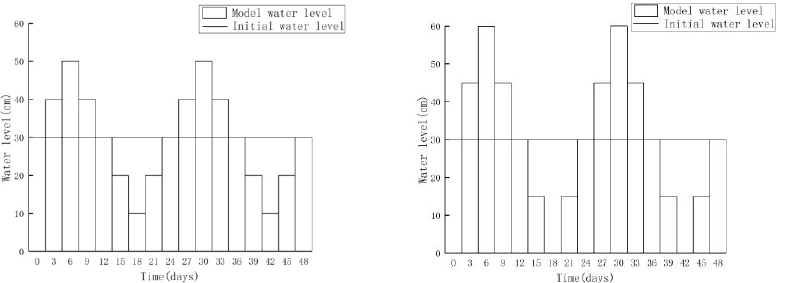
Figure 7. Comparison of water level changes.